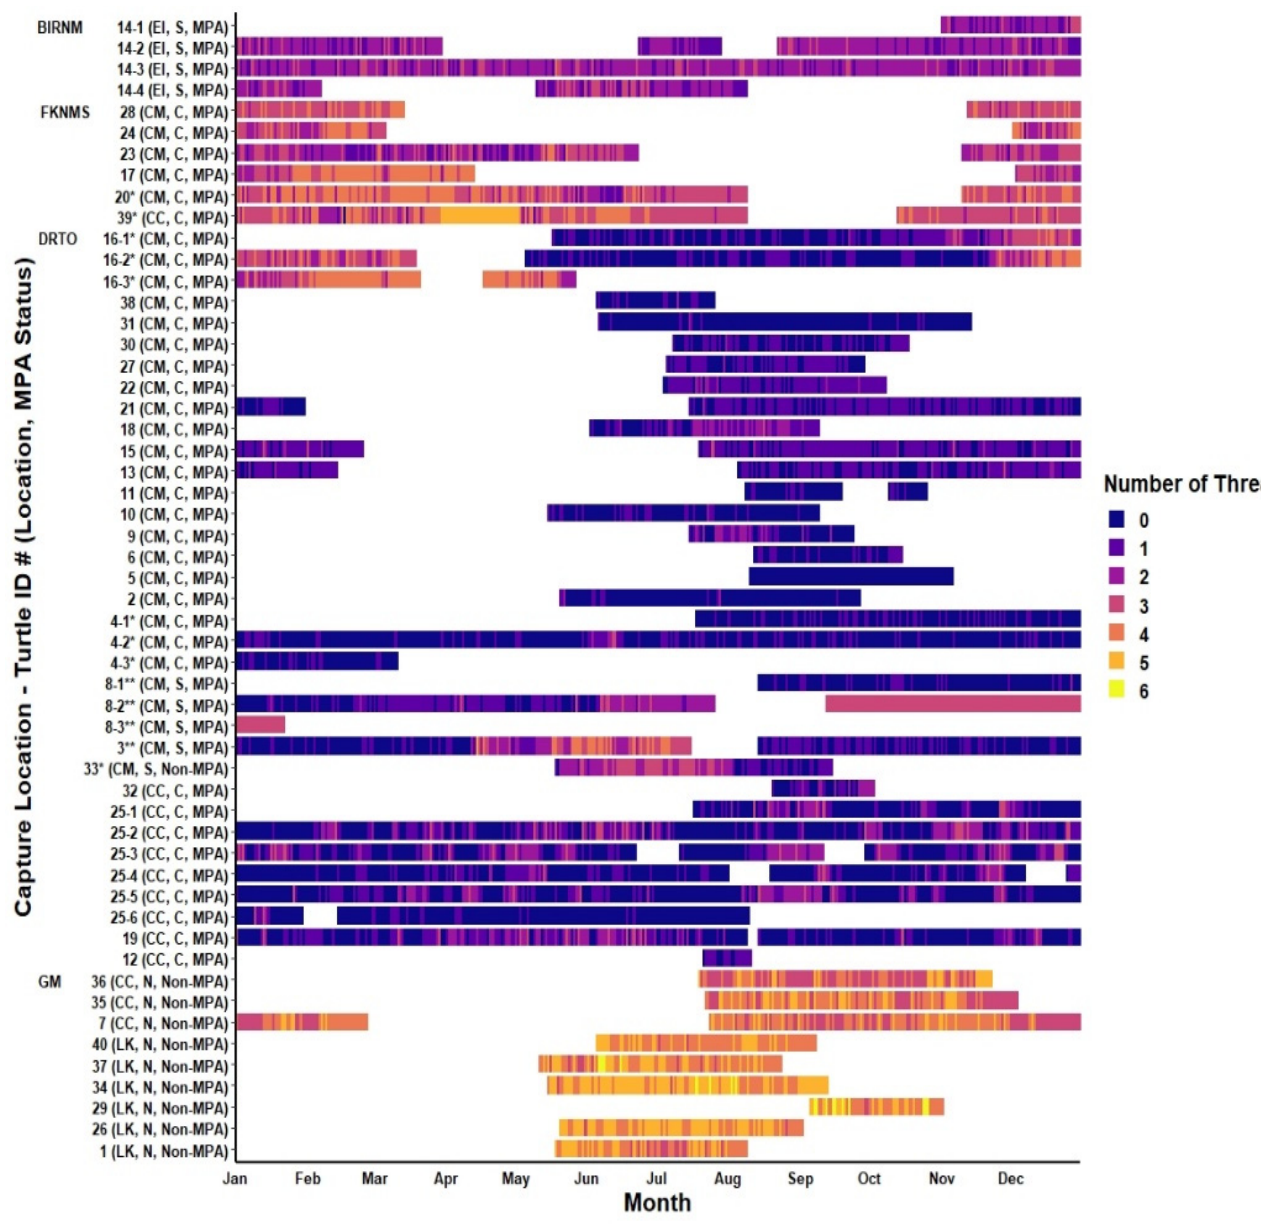
Figure 3. Number of high threat categories on a given day by each tagged turtle of our study. Data are sorted by capture location, species, geographic region (N = north, C = central, S = south), and Marine Protected Area (MPA) status (MPA or non-MPA designation). Missing data indicate lacking reliable tracking data or transmitters that terminated transmission before a given full calendar year. Turtles that have more than one calendar year of tracking data are displayed with a “-(number)” after their ID number. Asterisks (*) denote turtles that migrated, double asterisks (**) denote turtles that conducted migrations, but tracking data stopped before turtles returned to their foraging grounds. Acronyms are as follows: CC = loggerhead, CM = green, EI = hawksbill, LK = Kemp’s ridley.